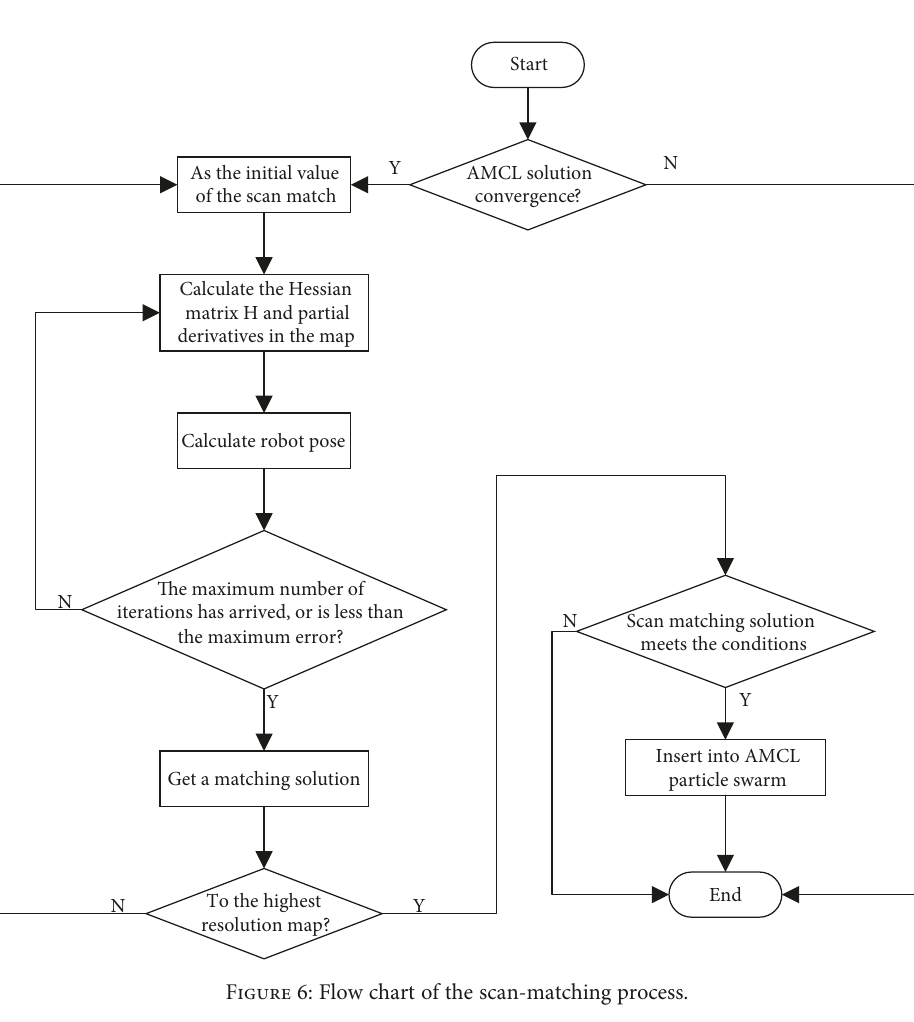
Figure 6: Flow chart of the scan-matching process.